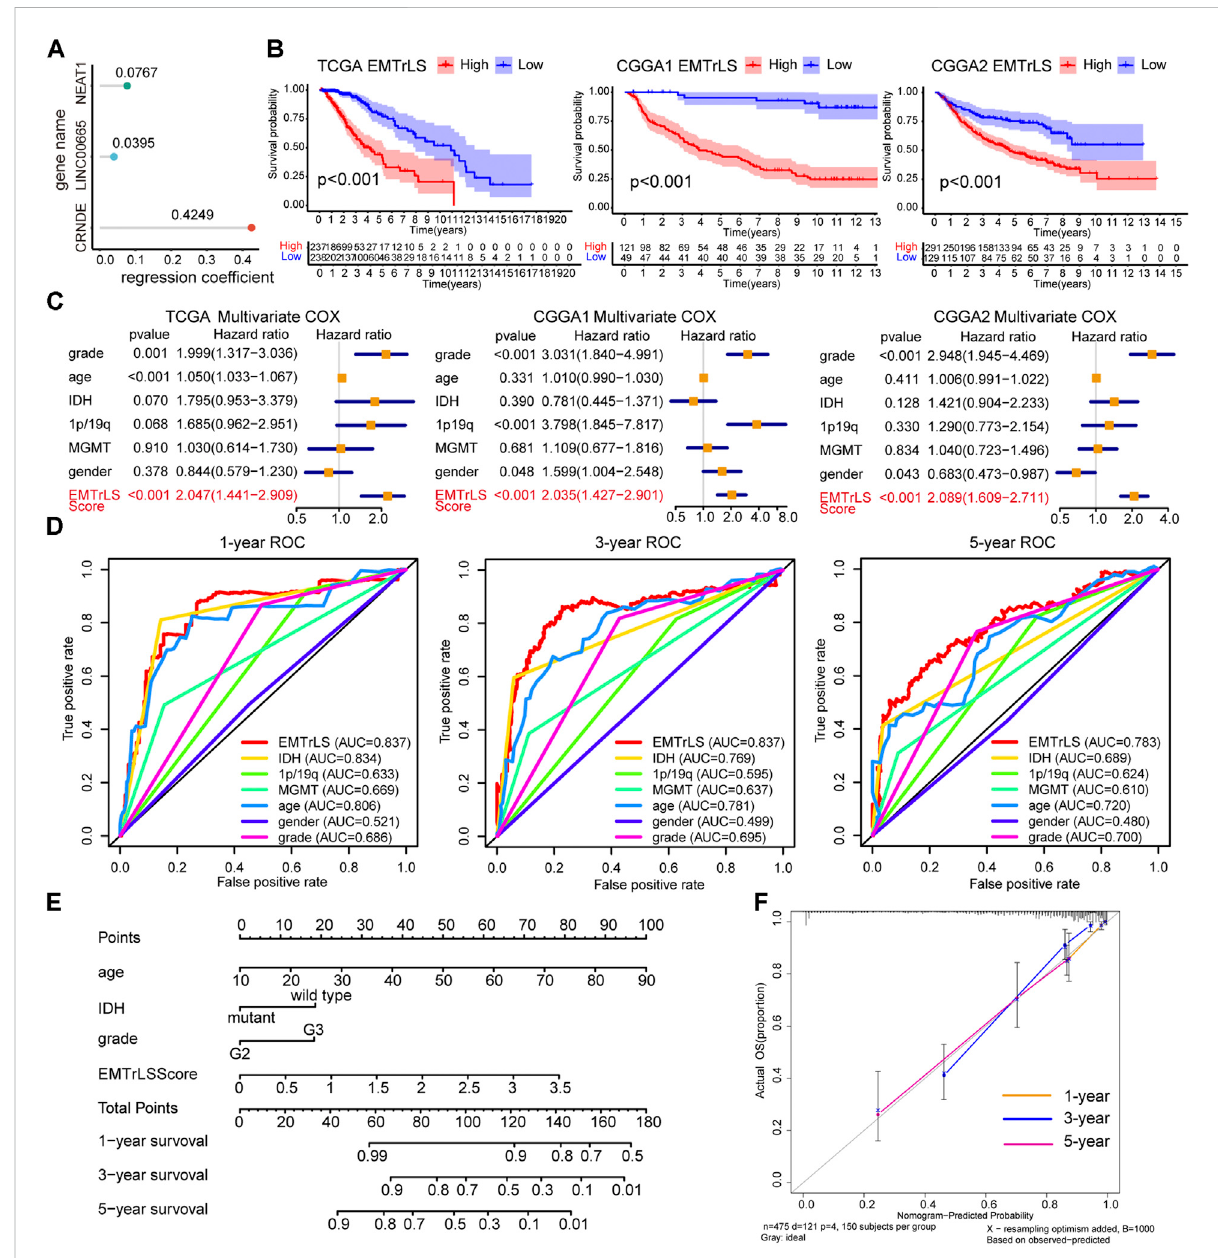
FIGURE 4 (A) LASSO regression coef fi cients of the three hub lncRNAs (B) K-M survival curves for EMTrLS-high and -low cohorts in the three datasets (C) Multivariate Cox regression analysis of EMTrLS scores, as well as WHO grade, age, IDH, 1p/19q, and MGMT status (D) ROC curves for the EMTrLS score and clinicopathological parameters including gender, grade, age, IDH, MGMT, and 1p/19q status in the TCGA dataset (one-, three-, and fi ve years) (E) Nomogram constructed based on EMTrLS score, age, IDH, and grade for clinical determination (F) Calibration plots of a nomogram predicting one-, three-, and fi ve-year survival